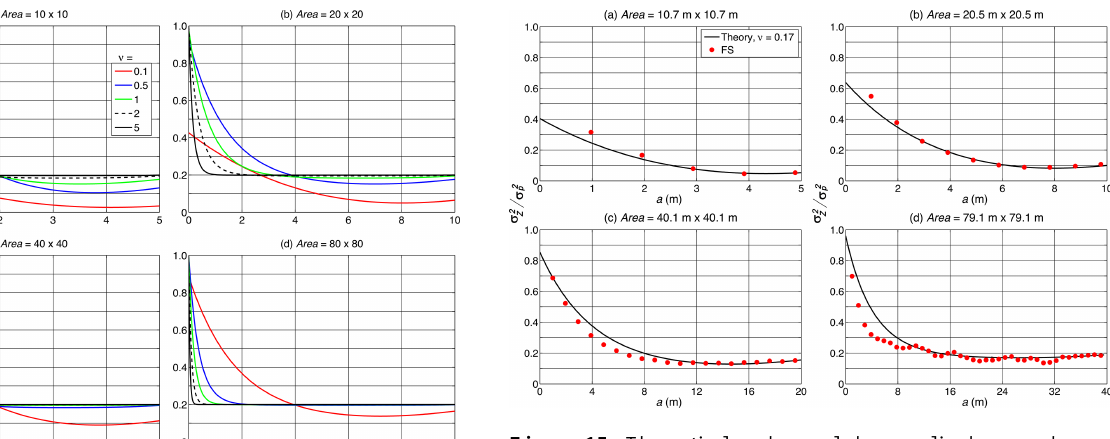
Figure 15. Theoretical and sampled normalized squared error . σ 2 p ) for the 5-point pattern in Fig. 12a over square areas of ( σ 2 . Z σ 2 p ) as a side dimensions ( L ) between 10.7 and 79.1m. The separation dis- Z tance (a) is varied from the center outwards. The solid line is the theoretical error derived for an exponential decay exponent of 0.17 derived from the sampled correlation function of snow depth in FS, while the solid red point markers are the sampled normalized squared error for the snow cover in